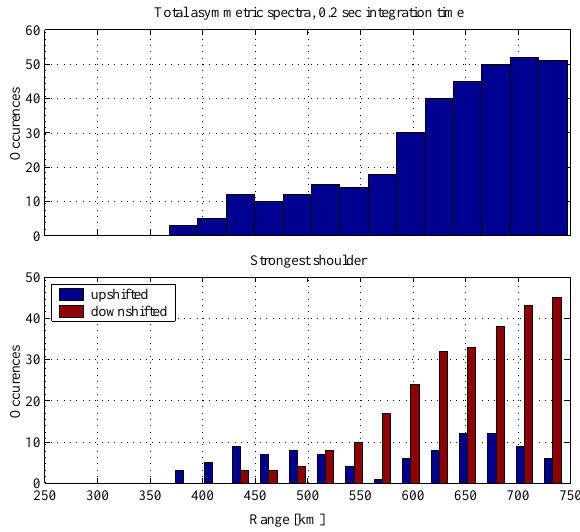
Fig. 10. Histograms showing occurrence of all observed coherent structures vs. range, showing their range and size. The top panel shows all events counted together, while the bottom panel counts up- and down-shifted enhancement separately.